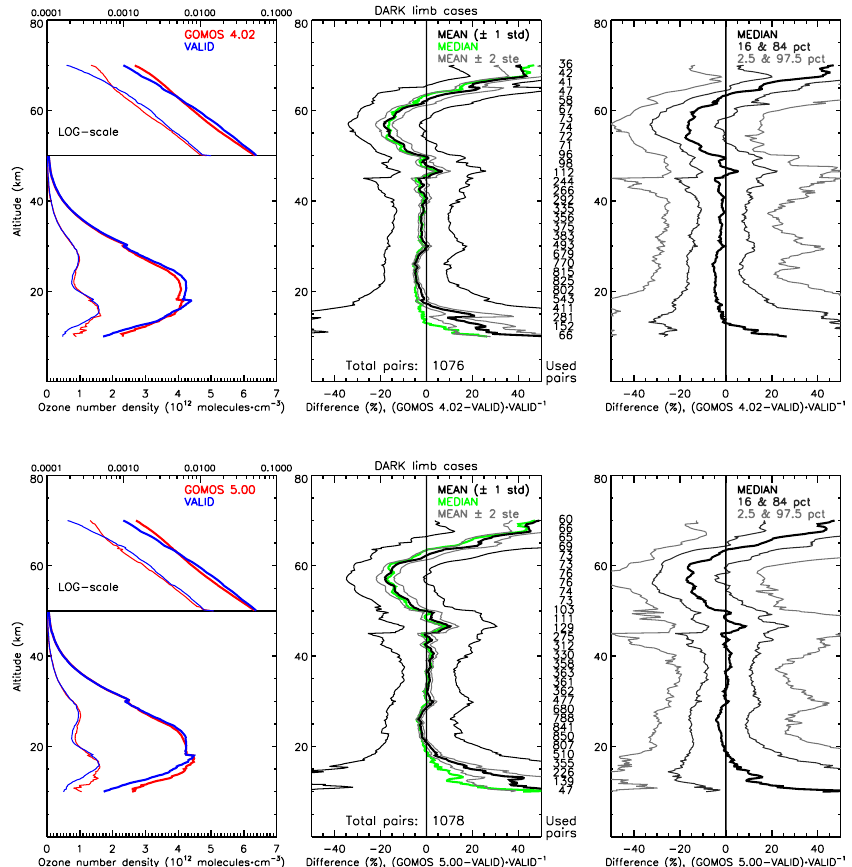
Fig. 2. As Fig. 1, except filtered for ozone values below 0 and above 10 13 molecules per cm 3 and with some Thule, Dumont d’Urville and Figure 2: As Figure 1, except filtered for ozone values below 0 and above 10 13 molecules per 3 Legionowo collocations cm 3 and with some Thule, Dumont d’Urville and Legionowo collocations removed. 4